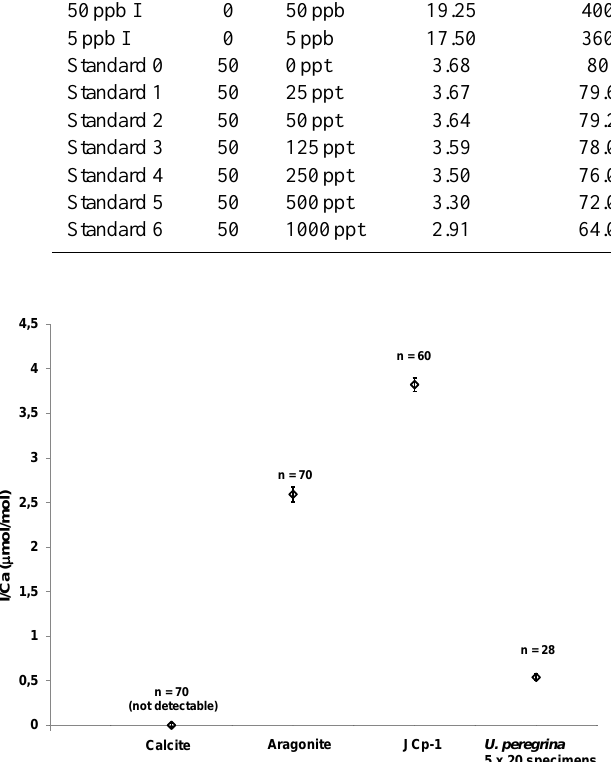
Figure 3. Mean I / Ca ratios, number of measurements ( n ) and er- rors (1SD) for the carbonate reference standards and 5 different samples of 20 U. striata specimens from the same location (M77-1-